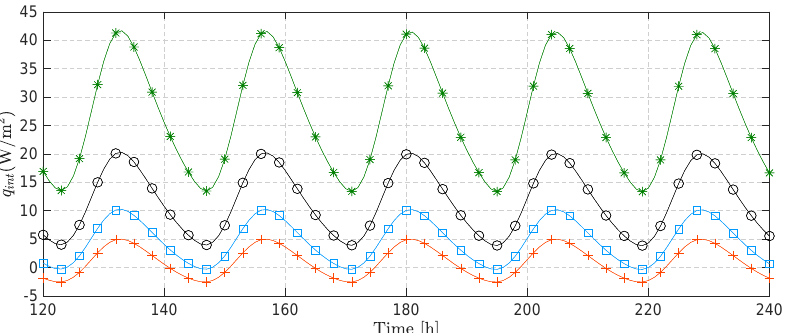
Figure 9. Heat flux distribution over time at the interior surface of the brick wall—sensitivity to leaf area index parameter, LAI : ( ∗ ) 1.5; ( ◦ ) 2.5; ( (cid:3) ) 3.5; (+) 4.5.